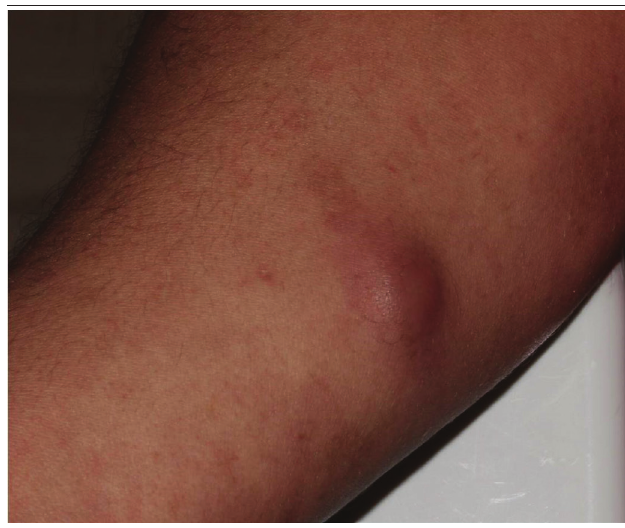
figurE 1 − Painless nodular lesion, about 4 cm long on the patient’s left arm